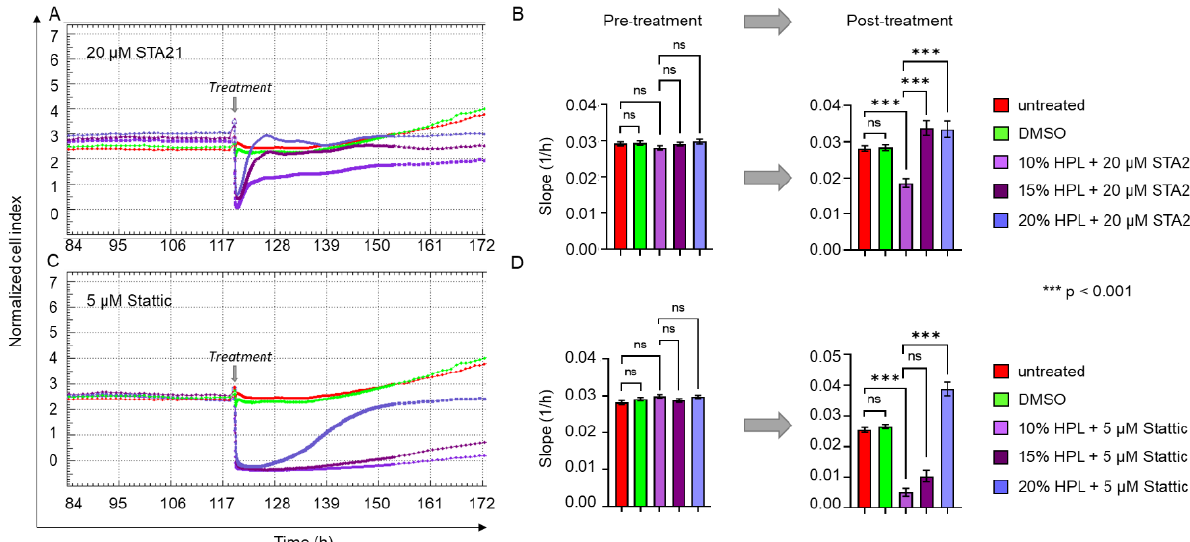
Figure 7. STAT3-inhibitor-induced reduction of cell proliferation can be reverted by increasing HPL concentrations. xCELLigence impedance measurements of BM-derived stromal cells grown in standard 10% HPL-supplemented medium and treated with either ( A ) 20 µM STA21 or ( C ) 5 µM Stattic. Treatment was carried out at the time indicated (grey arrow) and untreated cells (red) and DMSO only treated stromal cells (green) served as control. For the treatment with each of the two STAT3 inhibitors, three different concentrations of HPL were used: 10% (lilac), 15% (dark lilac) and 20% (violet) HPL-supplemented growth medium. Data shown are xCELLigence impedance meas- urements depicted as mean normalized cell index over time of one representative cell donor meas- ured in technical quadruplicates. ( B , D ) The rate of change of the cell index over time (slope 1/h) ± SD was calculated before and 24 h after the treatment with 20 µM STA21 ( B ) and 5 µM Stattic ( D ); ns = not significant.